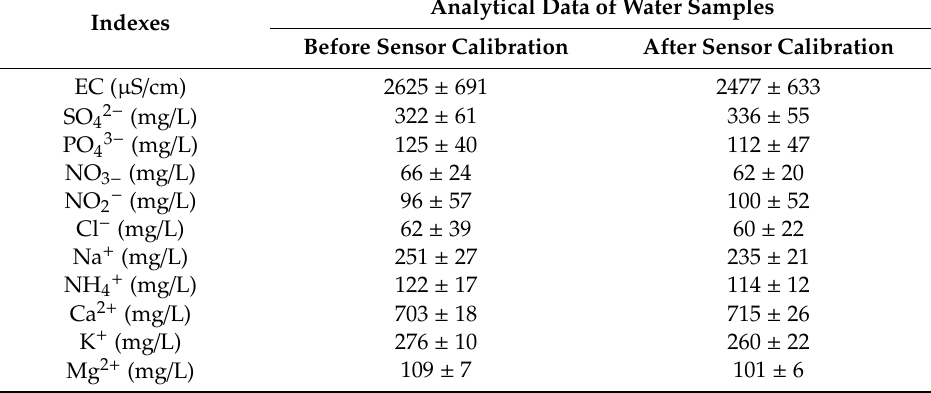
Table 4. Comparison of the electrical conductivity (EC) and concentrations of ions in di ff erent e ffl uent samples (n =